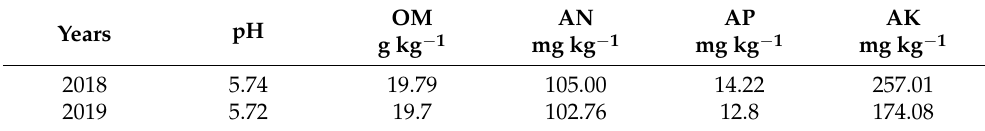
Table 1. Agro-chemical properties of test red soils.